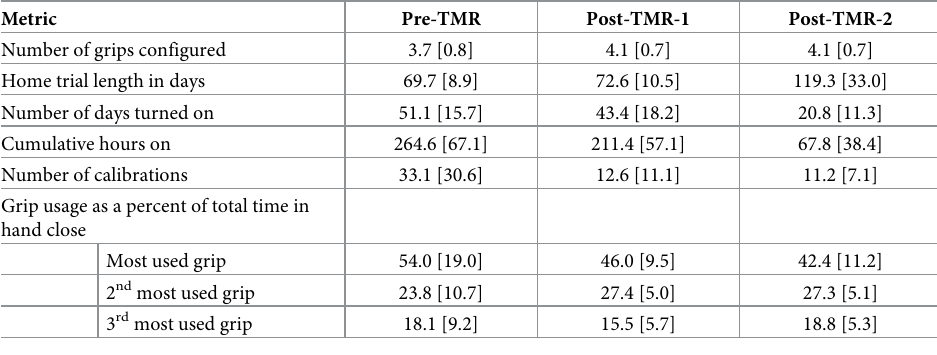
Table 2. Pre- vs post-TMR 8-week home trial usage data.